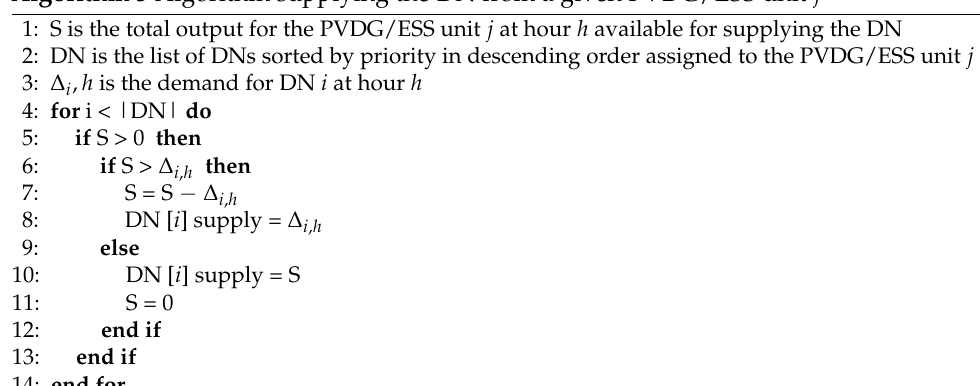
Algorithm 3 Algorithm supplying the DN from a given PVDG/ESS unit